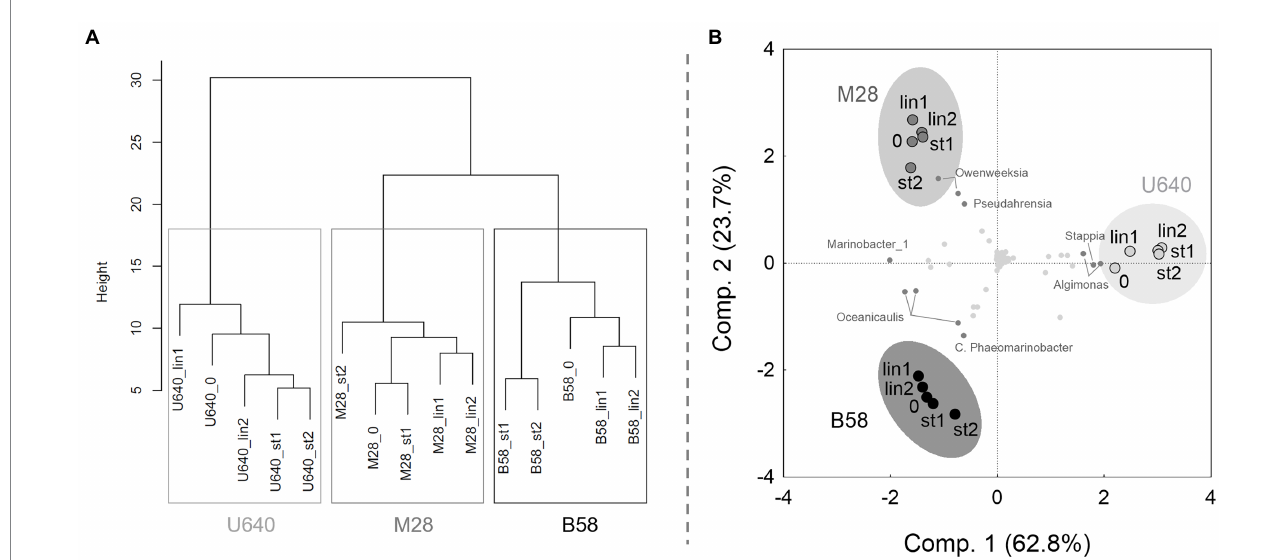
FIGURE 8 Statistical analysis of the microbiome data from the bubble column experiment. (A) Dendrogram and (B) PCA of the normalized bacterial community composition data. All sequenced OTUs were included in the calculations and are shown as grey dots in the PCA plot, and OTUs with largest impact are shown as dark gray dots with bacterial genus name. 0: start of the cultivation; lin, linear growth phase; st, stationary phase. Numbers 1 and 2 refer to the two biological